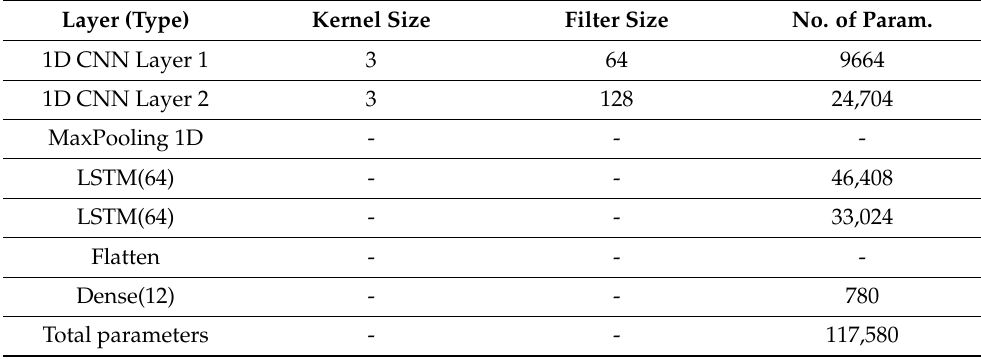
Figure 5. The overall framework of the proposed hybrid CNN-LSTM approach. Table 2. Parameters setting of our proposed